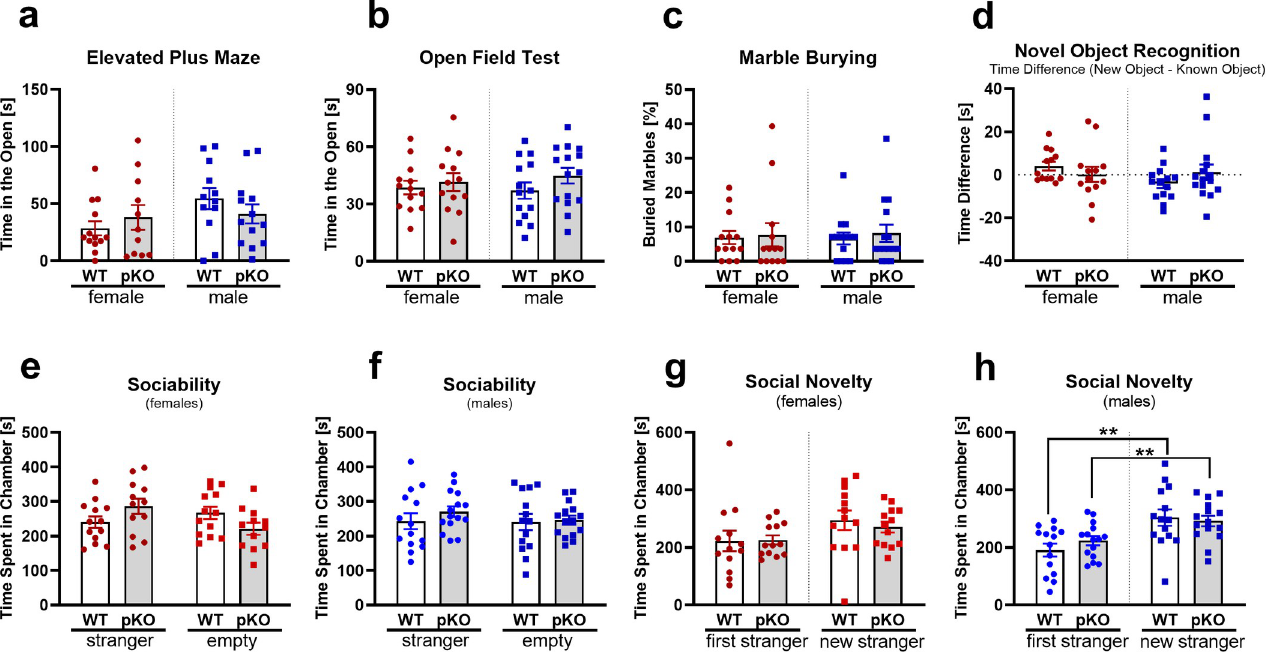
Fig 2. Social behavioral testing. Mest pKO mice showed no abnormalities in elevated plus maze (a), open field test (b), marble burying (c), novel object recognition (d), sociability (e, f) and social novelty (g, h) tests. 11–15 mice were analyzed per group and significance between groups was determined using an unpaired t-test. Data with 2 asterisks indicate P � 0.01.